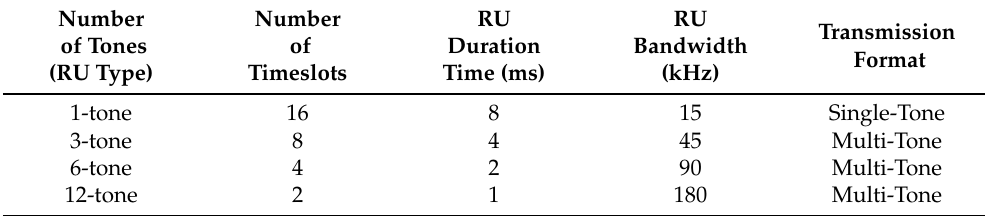
Transmission Format